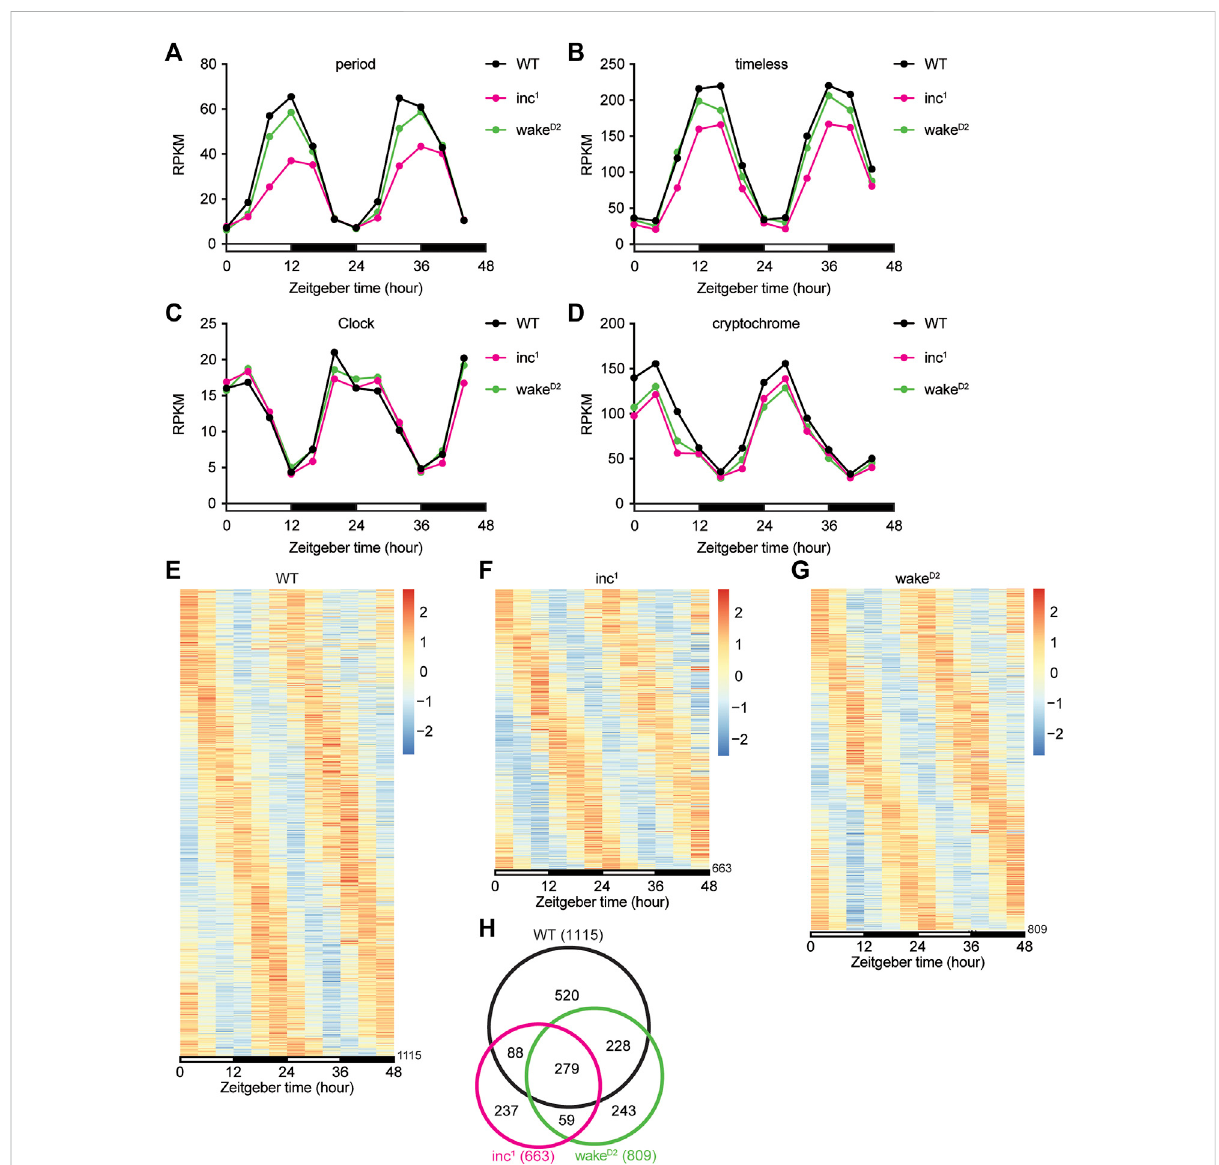
FIGURE 2 Chronicsleeplossby inc or wake mutationsdisruptscircadiangeneoscillation. (A – D) ReadsPerKilobaseoftranscript,perMillionmappedreads (RPKM) of period (A) , timeless (B) , Clock (C) , and cryptochrome (D) for WT (black), inc 1 (magenta), and wake D2 (green). x axis represents two 12-hour light/12-hour dark (LD) cycles with white bars representing daytime and black bars representing nighttime. For period , **** inc 1 and n.s. wake D2 . For timeless , **** inc 1 and n.s. wake D2 . For Clock , n.s. inc 1 and wake D2 . For cryptochrome, **** inc 1 and wake D2 . All comparisons are against WT , using Benjamini-Hochberg adjusted p values calculated by DESeq2 for time-series analysis. **** p < 0.0001; n.s., not signi fi cant. (E – G) Heatmaps of rhythmic genes in WT (E) , inc 1 (F) , wake D2 (G) groups. Each row represents one gene, and each column represents one timepoint. Expression levels are normalized to each gene itself and data are aligned according to the peak expression time calculated by JTK cycle. The blocked horizontal bars below the panel correspond to the light-dark cycle. (H) Intersection of rhythmic genes in WT (black), inc 1 (magenta), and wake D2